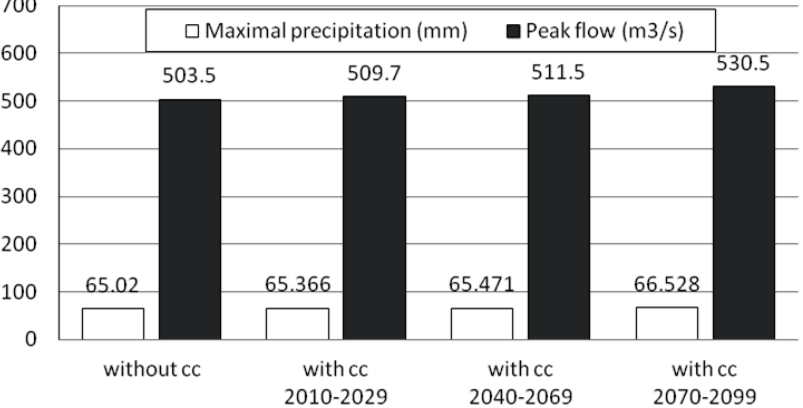
Fig. 1 Peak flows and maximum precipitation to different scenarios. Emission scenario